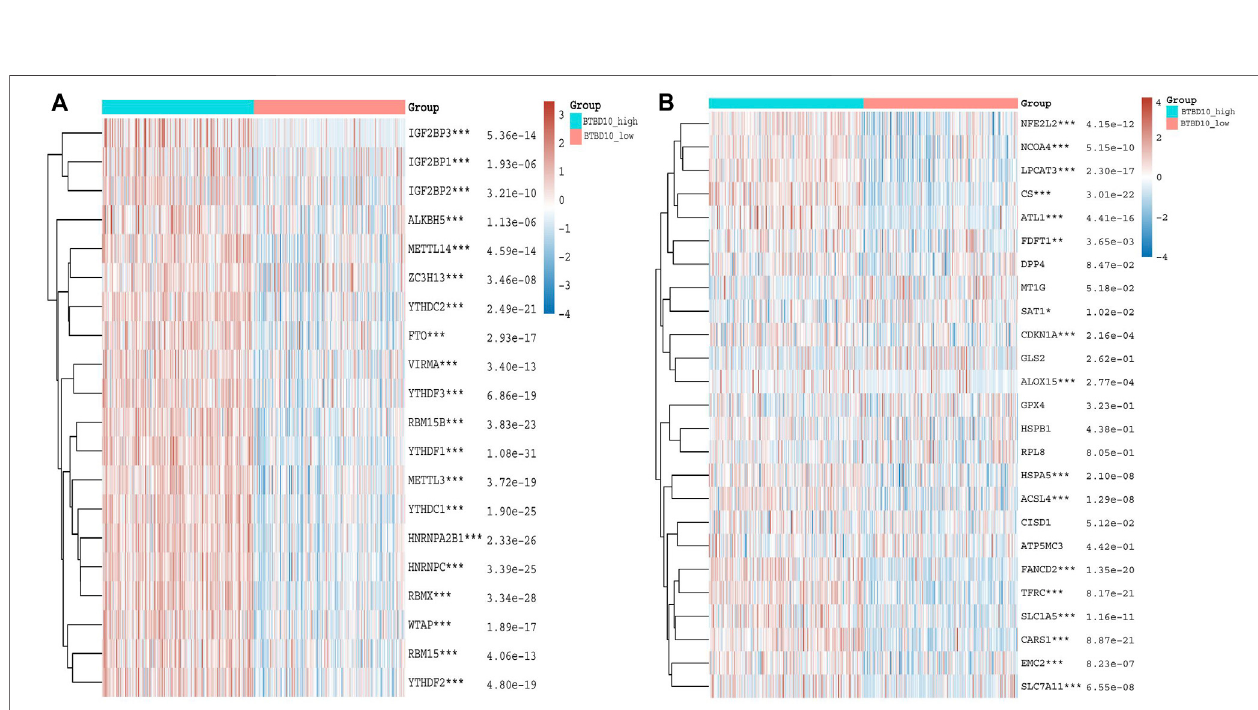
FIGURE 8 | (A) Heatmaps of m6A methylation-related genes expression in different BTBD10 expression groups using TCGA data (B) Heatmaps of ferroptosis-related genes expression in different BTBD10 expression groups using TCGA data.